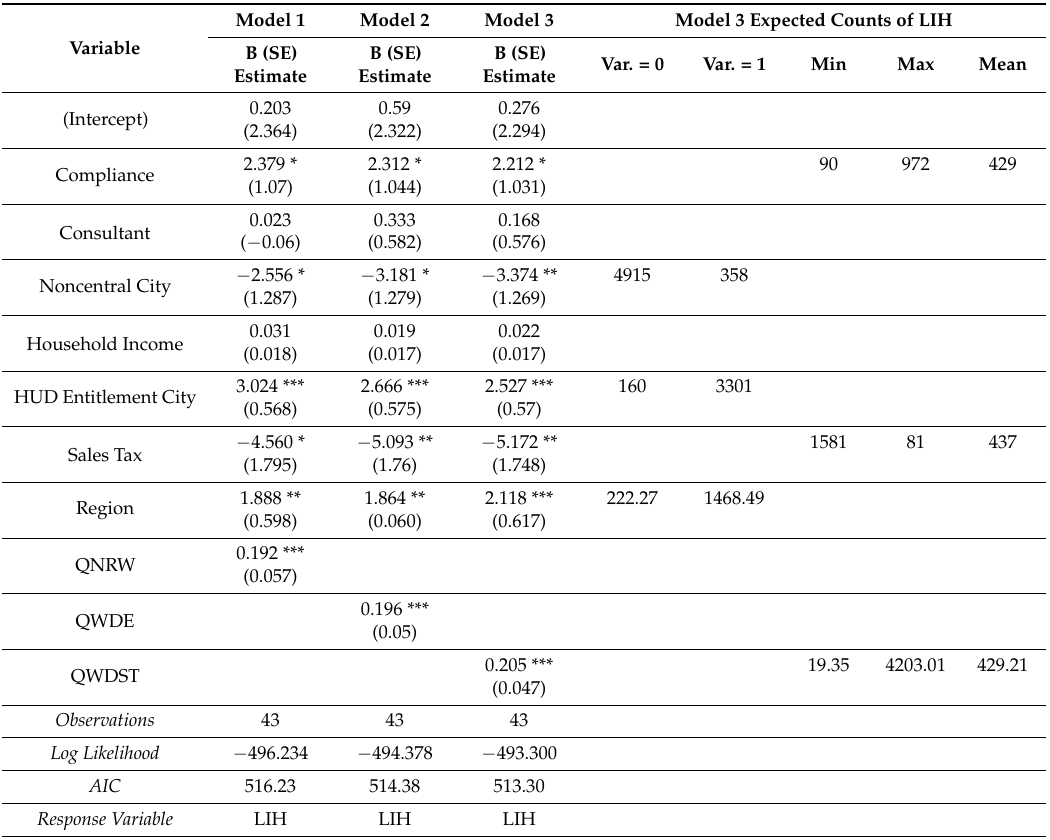
Table 9. The Negative Binomial Tests. In Models 1–3, the quality measures (QNRW, QWDE, and QWDST) maintained statistically significant relationships with Low-income Housing